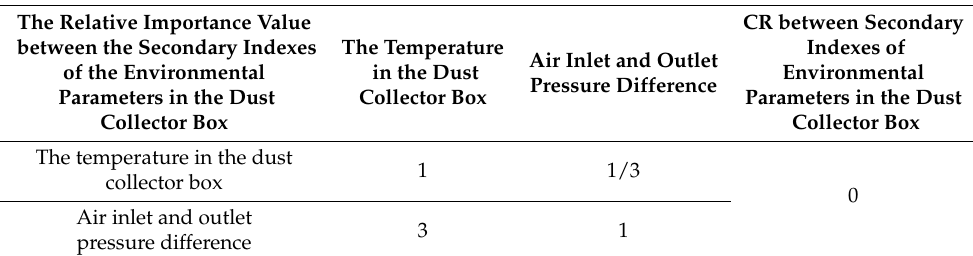
Table 9. Examples of experts’ judgment matrix and consistency test results for the evaluation indicators between the secondary indicators of environmental parameters in the dust collector box.